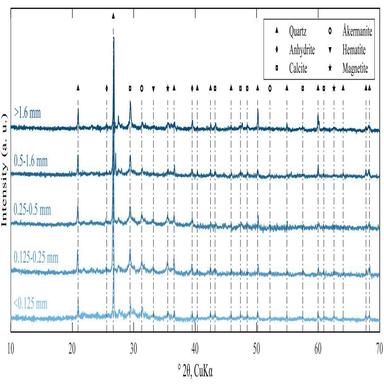
XRD patterns of as-received BA samples from different particle fractions.